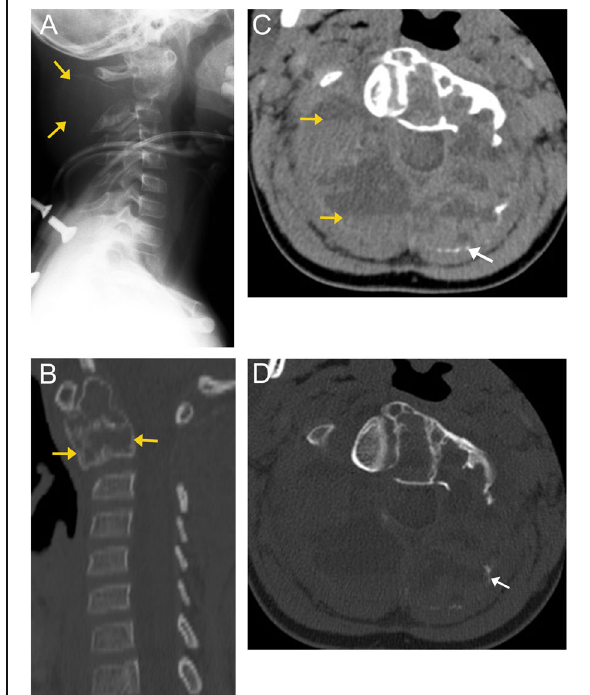
Fig. 9 Aneurysmal bone cyst. Lateral radiograph ( a ) of the cervical spine demonstrates a large, osteolytic, expansile mass arising from the C2 vertebral body, resulting in significant bony remodeling. The mass is sharply defined and demonstrates thin sclerotic margins, also known as an “ eggshell cortex ” (orange arrows). Sagittal CT image of the cervical spine ( b ) confirms the lesion within the C2 vertebral body. Axial CT image in the soft tissue window ( c ) shows fluid-fluid levels (orange arrows), compatible with hemorrhage. Axial CT image in the bone window ( d ) shows near complete obliteration of the posterior arch with some areas of remnant thin sclerotic rim, "eggshell cortex" (white arrow)